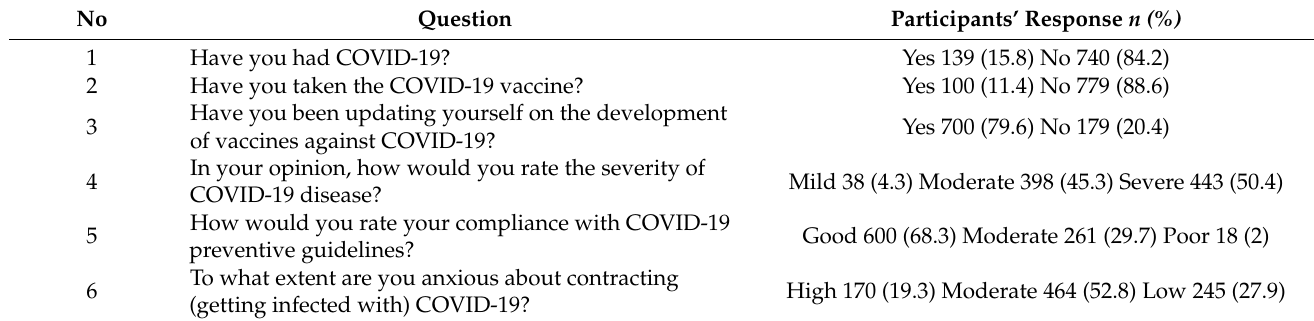
Table 2. General questions regarding COVID-19.